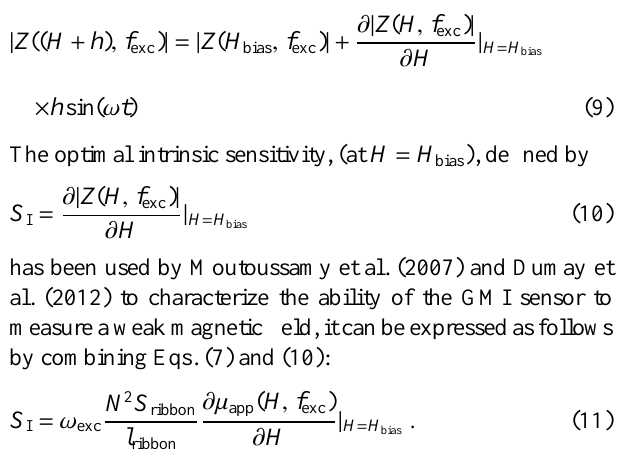
Figure 5. Signal conditioning principle.